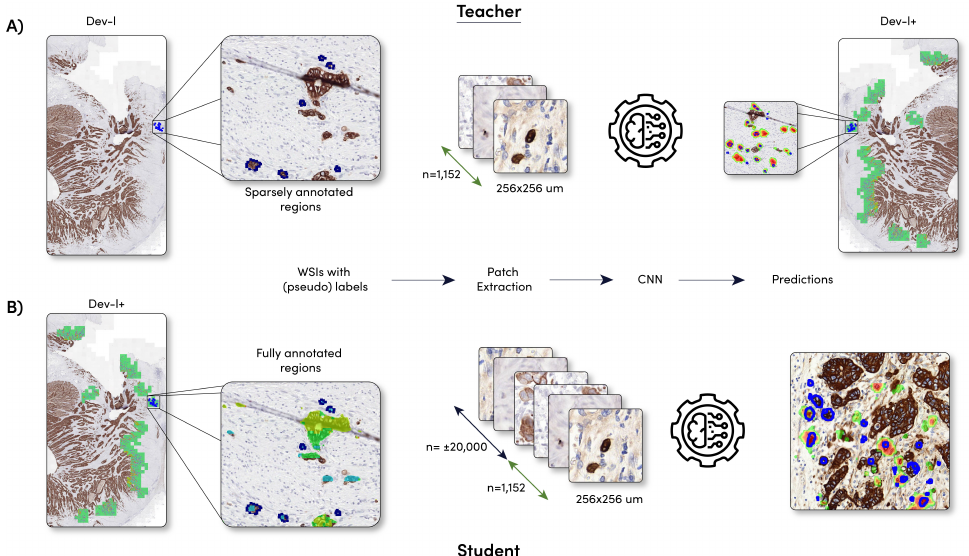
Figure 2. Schematic overview of the model development. ( A ) Training of the two teacher models (DenseNet and faster R-CNN) and the sparse dataset dev-l. Note that the 1152 candidates consist of 680 + 472 tumor bud/non-tumor-bud candidates, respectively; ( B ) training of the student models (DenseNet and faster R-CNN) and the fully exhaustive dataset dev-l+. Dataset dev-l+ was created by applying the teacher model to dataset